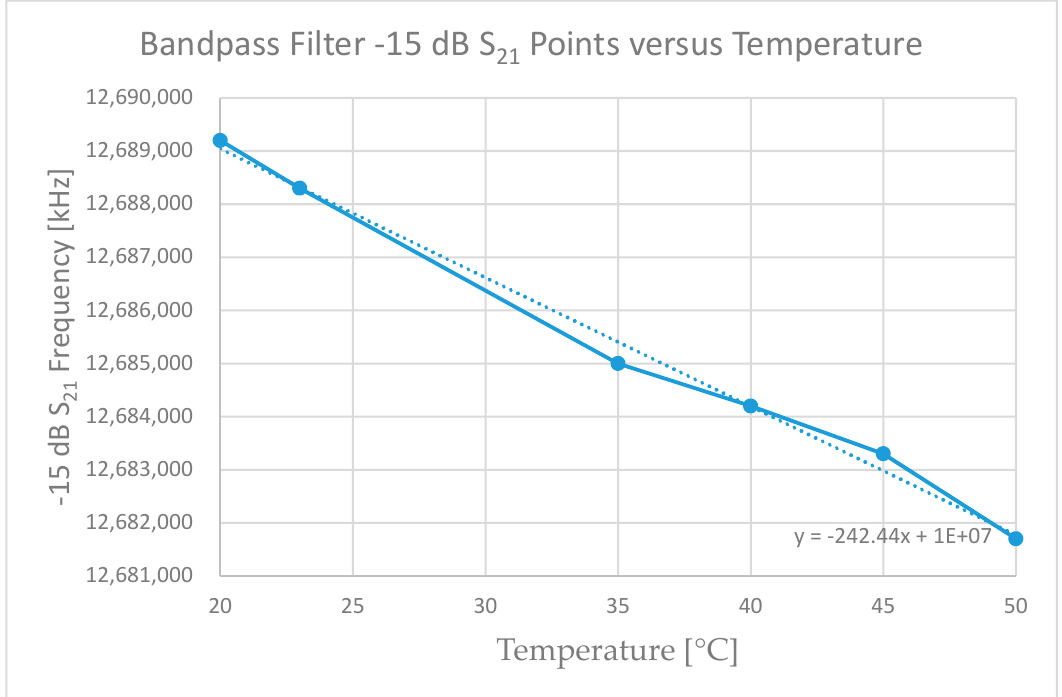
Metals 2020 , 10 , x FOR PEER REVIEW Figure 10. Bandpass Filter -15 dB S 21 Points versus Temperature. Figure 10. Bandpass Filter -15 dB S 21 Points versus Temperature.